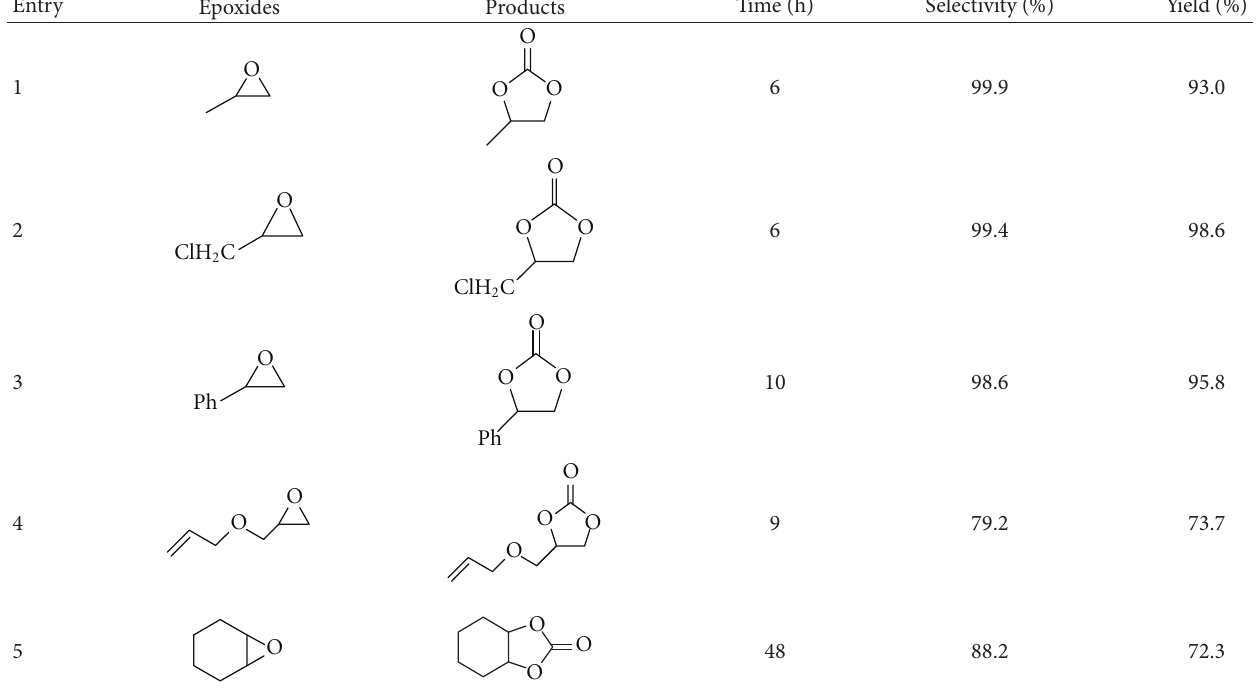
to different epoxides. 2